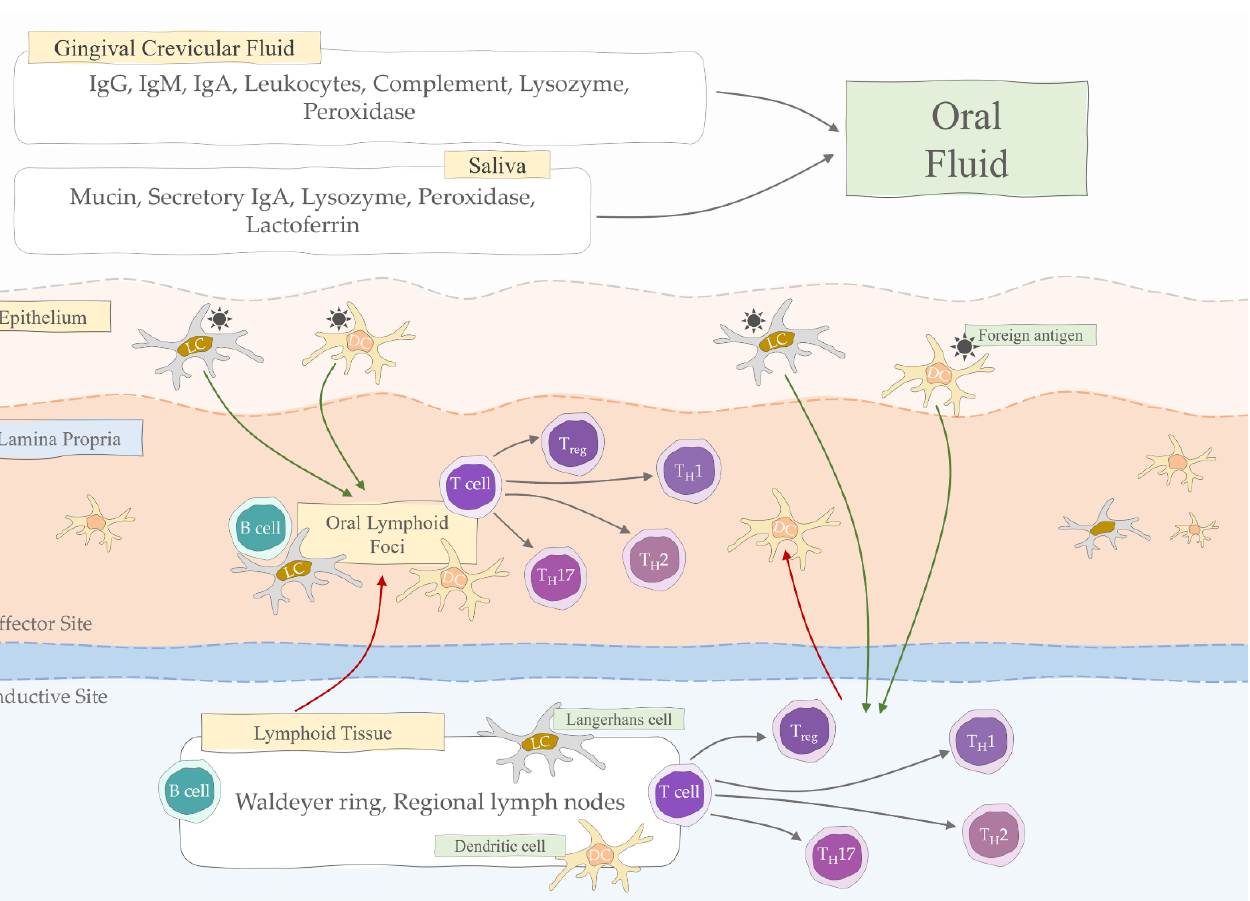
Figure 1. Oral mucosal immunity (Treg, regulatory T cells; TH, helper T cells; DC, dendritic cell; LC, Langerhans cell; IgA, immunoglobulin A; IgG, immunoglobulin G; IgM, immunoglobulin